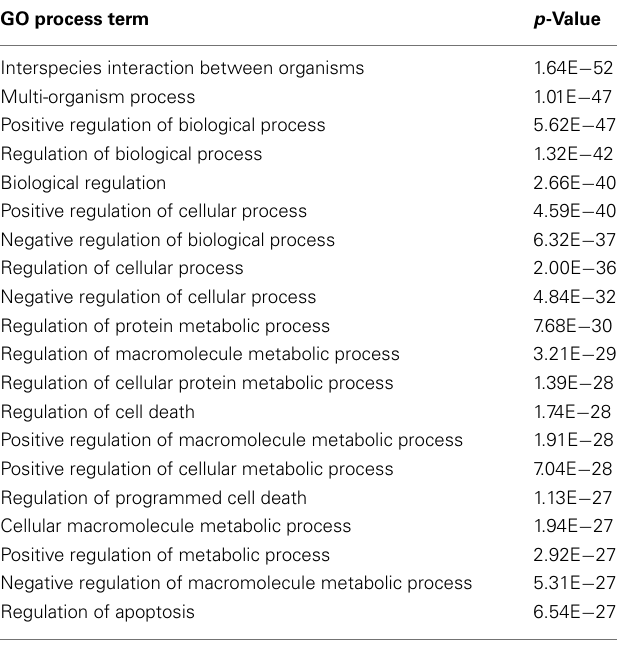
Table 5 | First 20 enriched GO process terms in human proteins targeted by both bacterial and viral groups (bacteria–virus-targeted